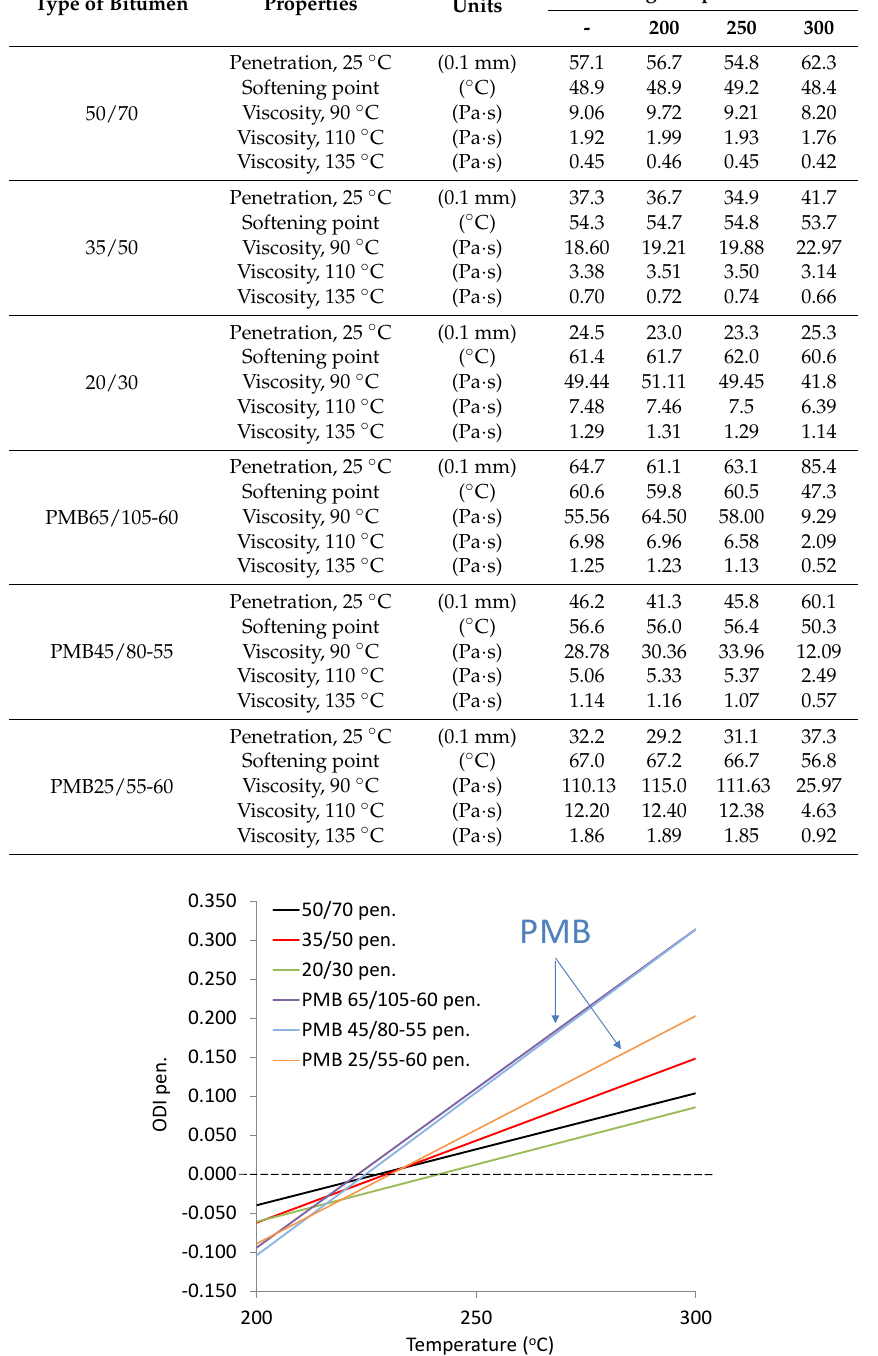
Figure 3. Overheating Degradation Index for binder 50/70 and determination of temperature T (ODI) . Figure 4. Overheating Degradation Index for binder 35/50 and determination of temperature T (ODI) .